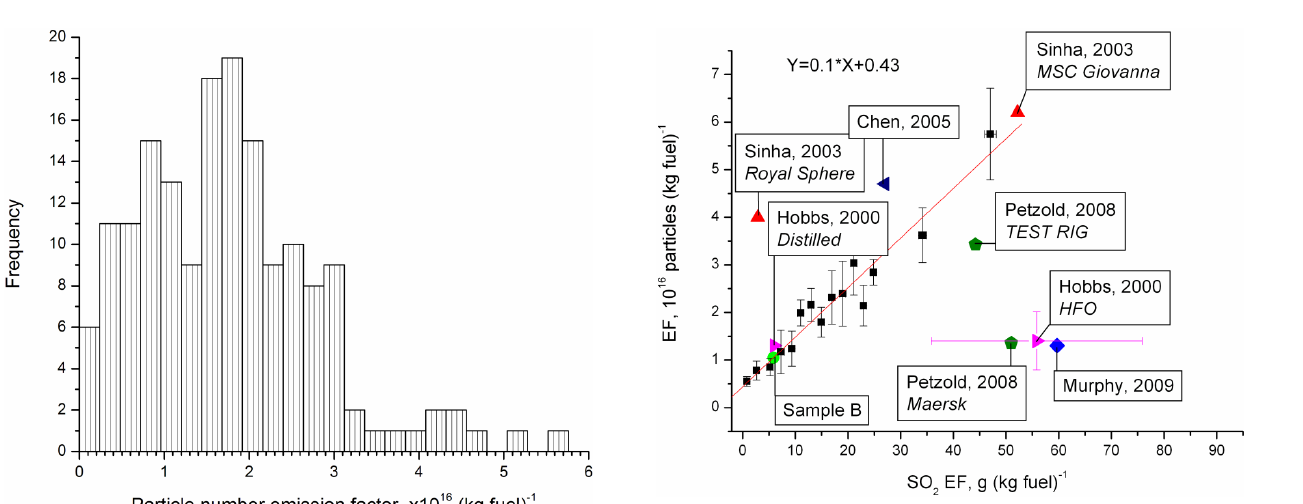
Fig. 12. Distribution of particle emission factors of the studied Figure 12. Distribution of particle emission factors of the studied ships. The total 1023 ships. The total particle EF range was divided into 24 EF bins. Fre- quencies of the EF bins are plotted along the y-axes. particle EF range was divided into 24 EF bins. Frequencies of the EF bins are plotted 1024 along the y-axes. 1025